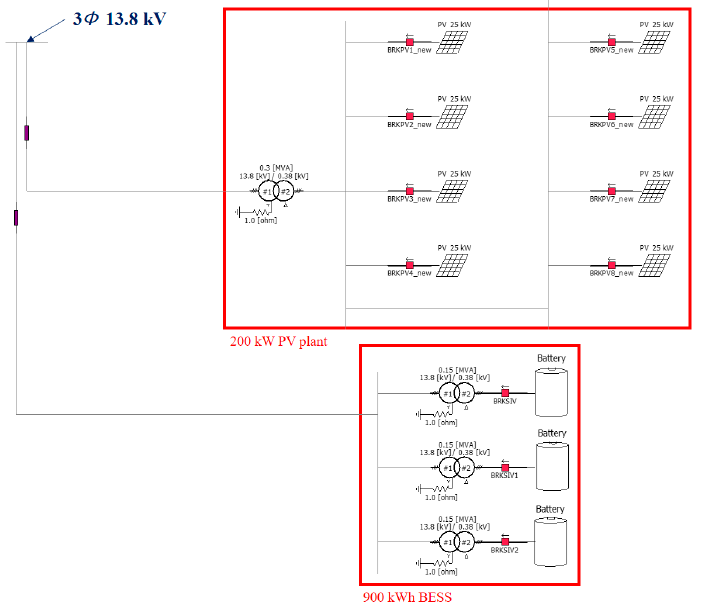
Figure 8. Photovoltaic (PV) plant and battery energy storage system (BESS) simulation models in PSCAD/EMTDC.